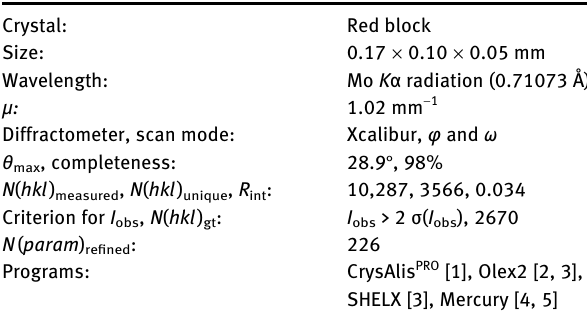
Table  : Data collection and